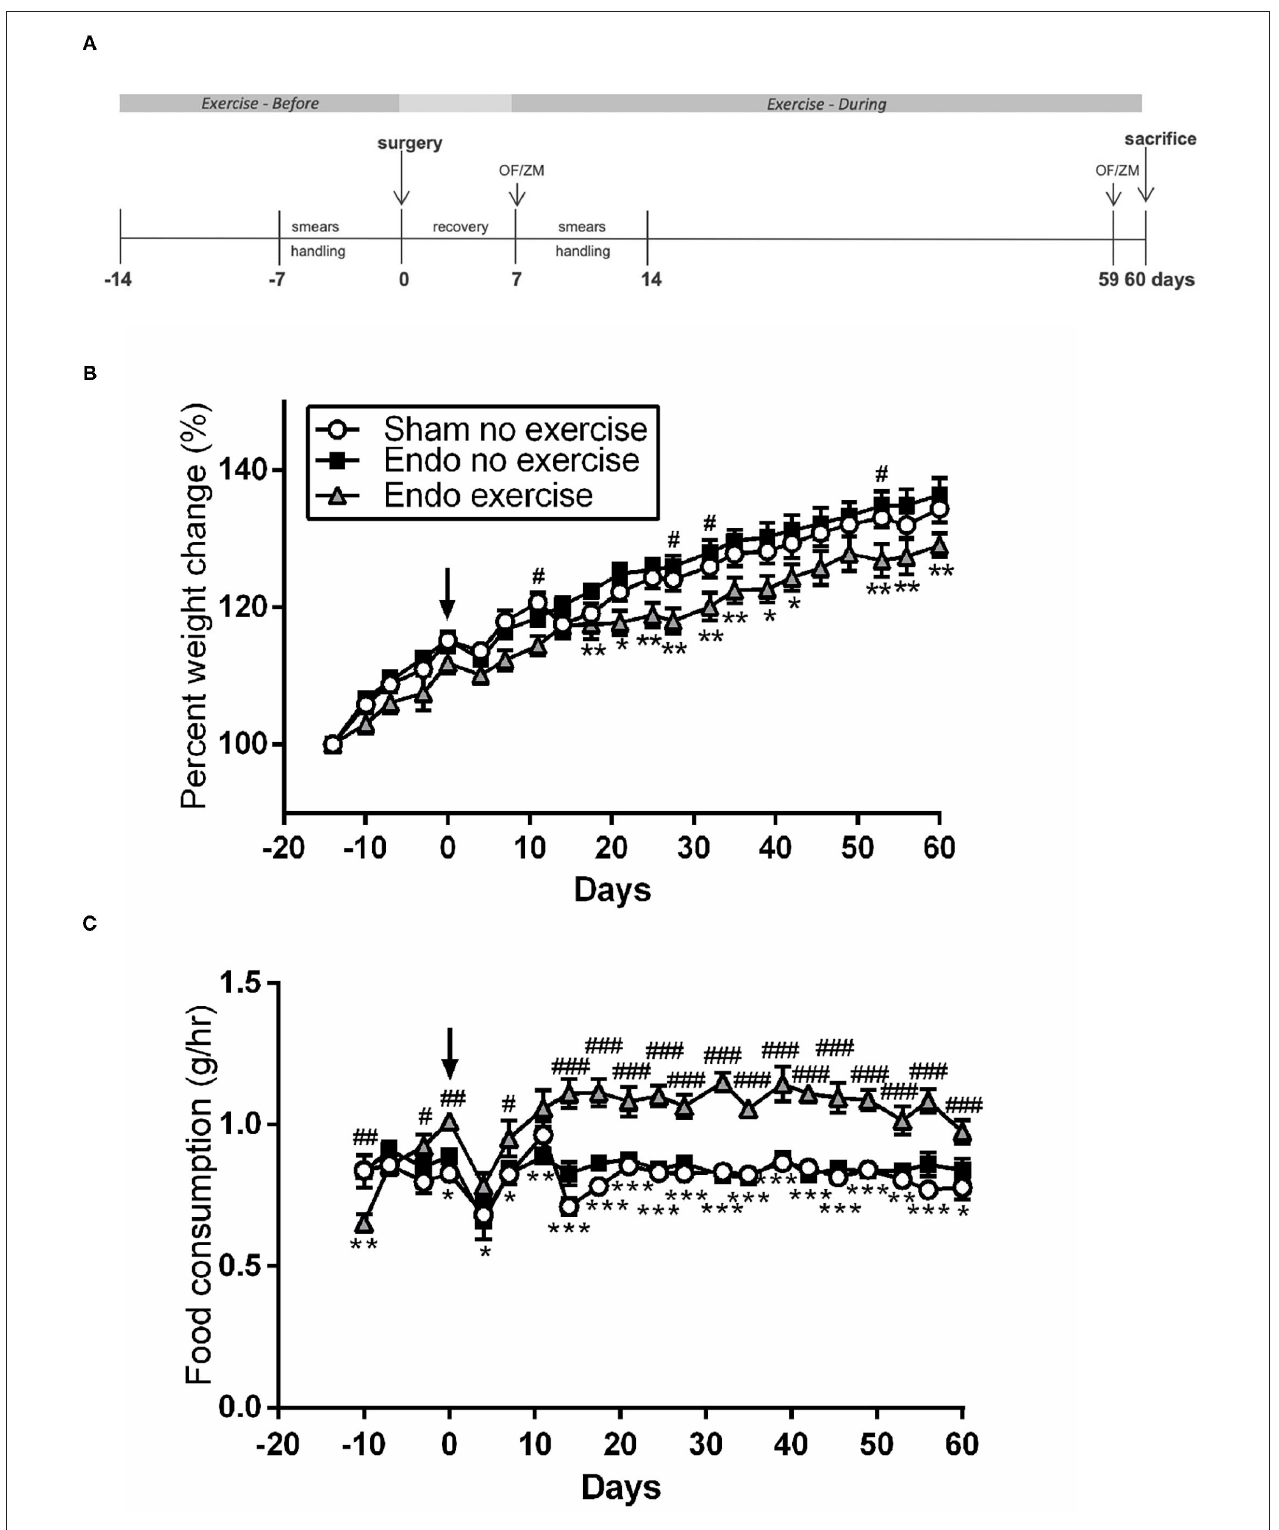
FIGURE 1 | Exercised animals gained less weight while eating more. (A) Exercised animals had voluntary access to a running wheel from prior to endometriosis induction until time of sacrifice (OF, open field; ZM, zero maze). (B) Weight change throughout the study. (C) Food consumption comparison between treatment groups ( n = 9–10/group ± sem; * p < 0.05, ** p < 0.01, *** p < 0.001 Endo-No exercise vs. Endo-Exercise; # p < 0.05, ## p < 0.01, ### p < 0.001 Sham-No exercise vs. Endo-Exercise; arrow represents time of surgery).